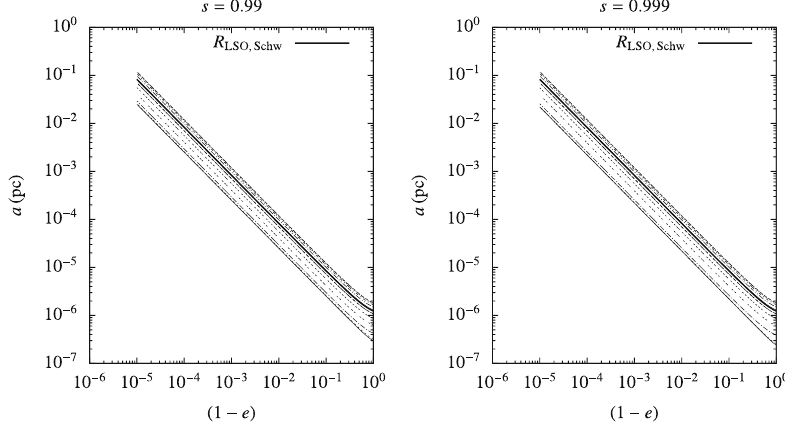
Fig. 58 The same as in Fig. 57 but for a spin of s = 0 . 99 (left) and s = 0 . 999 (right panel). The larger the spin, the “further away” the Kerr LSO gets from the Schwarzschild LSO